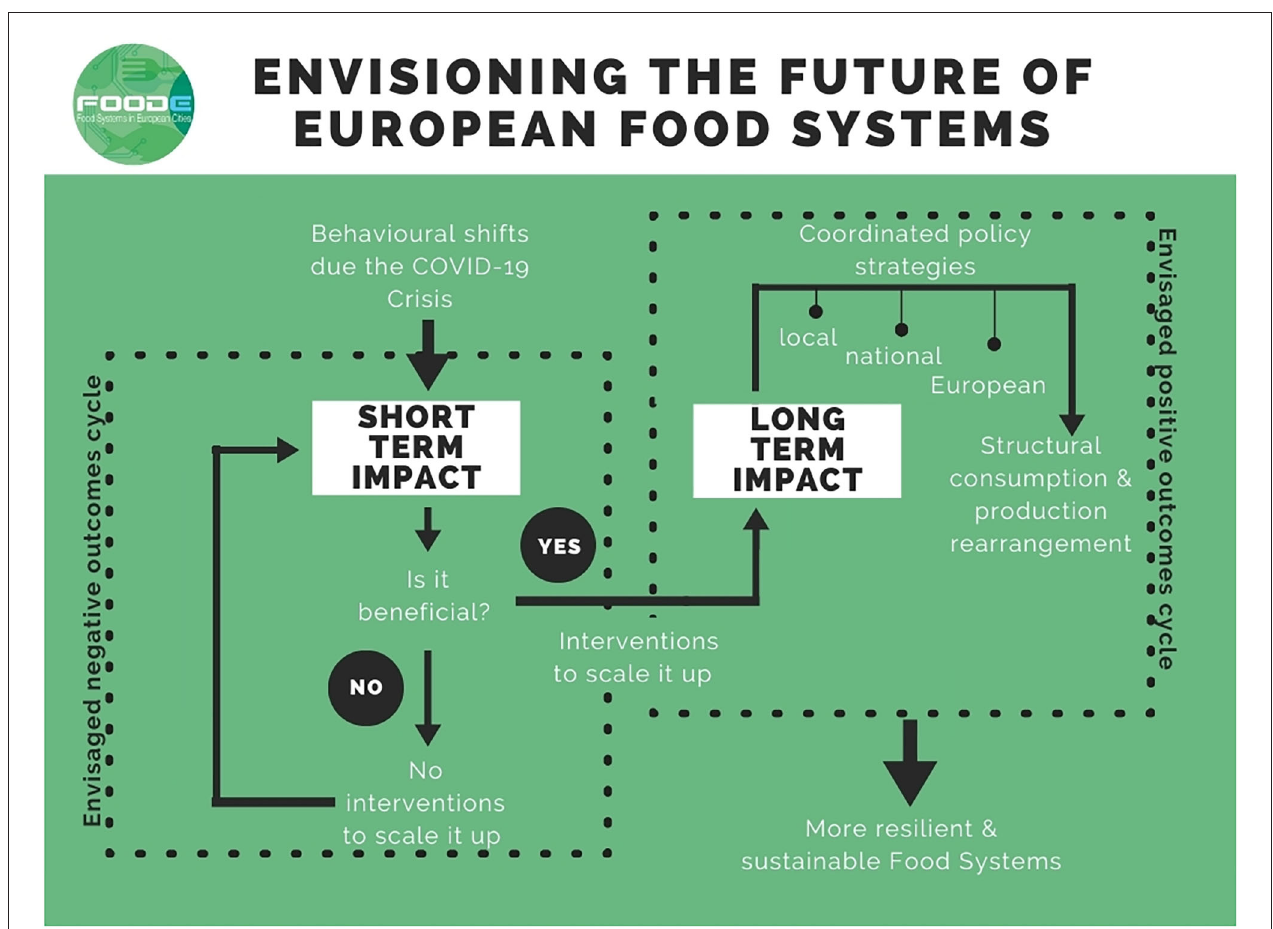
FIGURE 2 | Impacts on the European CRFS—Envisaged negative and positive outcomes